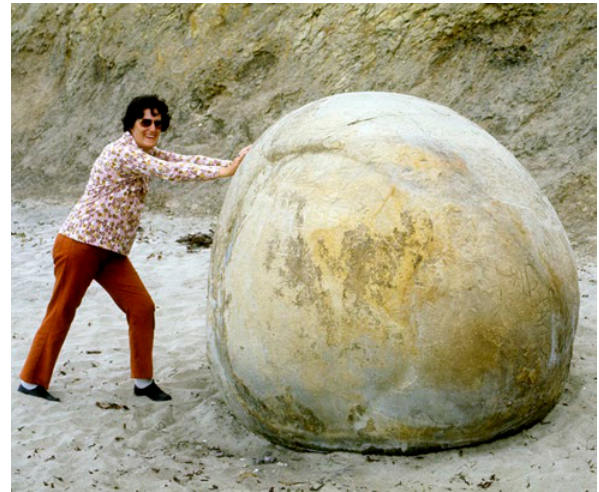
Figure 69. A very large calcareous concretion has weathered out of soft shales. It is at Moeraki, south of Timaru, New Zealand. Rapid shoreline erosion of the bank of soft shale is exposing a number of these concretions which are left on the beach as the “Moeraki Boul- ders”. The size of the concretion indicates that the process is self- perpetuating and can continue as long as hydroxy-carbonate parti- cles can diffuse to its surface.